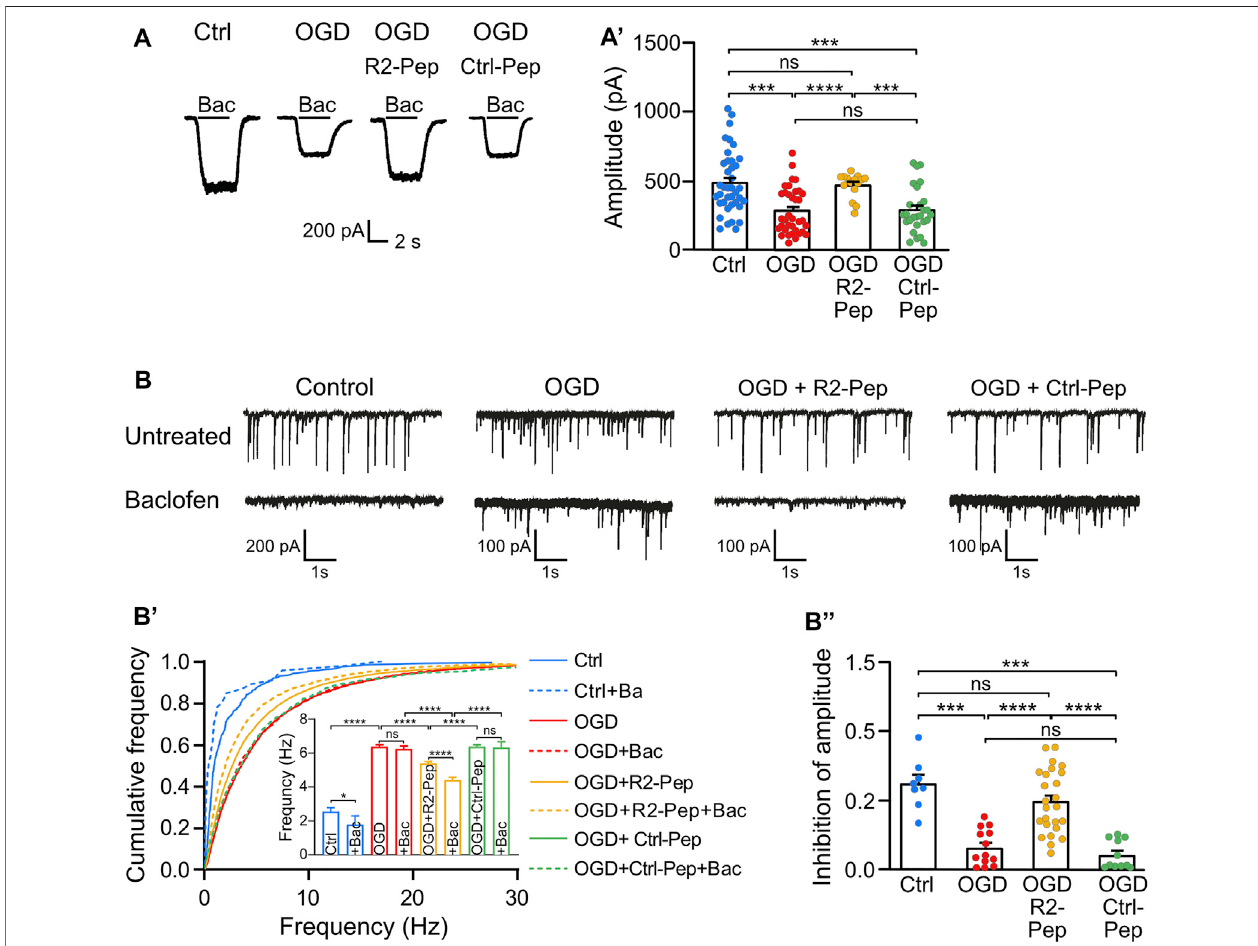
FIGURE 6 | Treatment of OGD-stressed neurons with R2-Pep restores GABA B receptor-mediated inhibition. (A) R2-Pep restored OGD-induced downregulated GABA B receptor-mediated K + currents. Representative traces of baclofen-induced K + currents were recorded in untreated neurons or OGP-treated neurons in the presence or absence of R2-Pep or the inactive Ctrl-Pep. (A 9 ), Quantitative evaluation of K + current amplitudes. The data represent the mean ± S.E.M. of Ctrl: n = 39, OGD: n = 36, OGD + R2-Pep: n = 15, OGD + Ctrl-Pep: n = 27. Ns, p > 0.05; ***, p < 0.001 ****, p < 0.0001, Brown-Forsythe/Welch one-way ANOVA followed by Dunnett ’ s T3 multiple comparison test. (B) Treatment of OGD-stressed neurons with R2-Pep restores baclofen-induced inhibition of the amplitude and frequency of spontaneous postsynaptic currents (sPSCs). Representative current traces depicting sPSCs recorded from untreated neurons and OGD-stressed neurons in the absence or presence of R2-Pep or the inactive Ctrl-Pep. (B 9 ) , Cumulative frequency histogram of inter-event-intervals of sPSCs recorded from cells without (solid lines) orwithbaclofen(dashedlines).Ns, p > 0.05;*, p < 0.05;****, p < 0.0001;Kruskal – WallistestfollowedbyDunn ’ smultiplecomparisontest(Ctrl: n =8,OGD: n =13,OGD +R2-Pep: n =25,OGD+Ctrl: n =11). (B ” ) ,InhibitionofsPSCamplitudesbybaclofen.Meanamplitudesvalueswerenormalized tothecontrolconditionoftheindividual neuron. Ns, p > 0.05; ***, p < 0.001; ****, p < 0.0001; Brown-Forsythe/Welch one-way ANOVA followed by Games-Howell ’ s multiple comparison test (Ctrl: n = 8, OGD: n = 13, OGD + R2-Pep: n = 25, OGD + Ctrl-Pep: n =